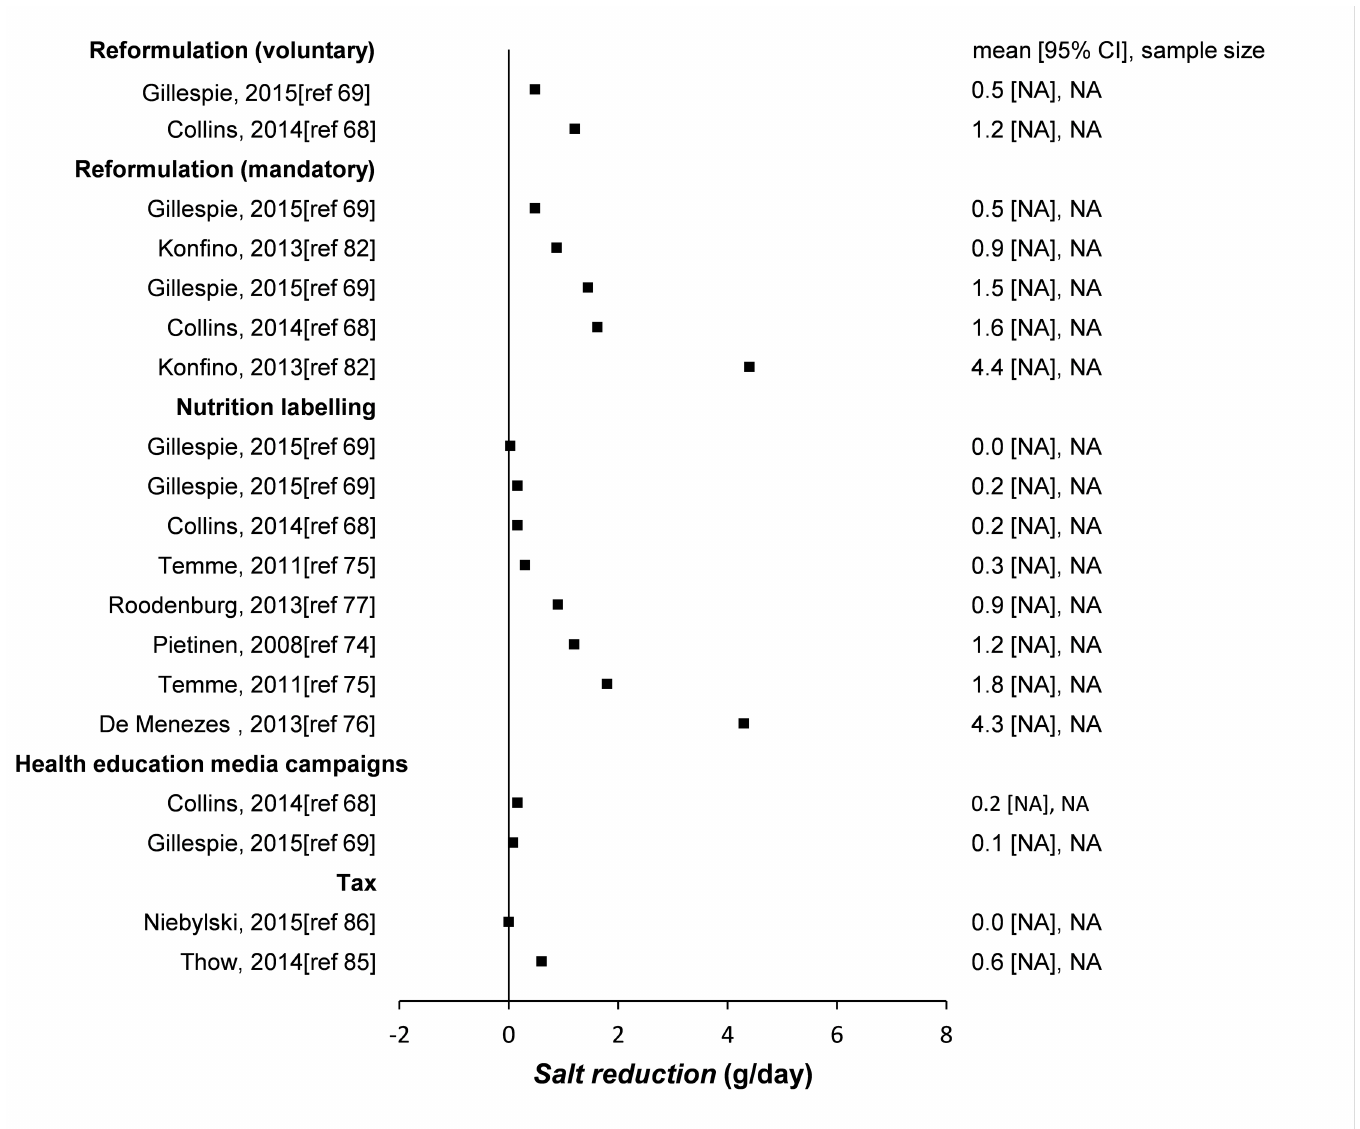
Fig 4. Effectiveness of interventions to reduce salt intake (modelling studies). Forest plot of the modellingstudies that were includedin this systematic review. Because of the different modelling approachesin these studies, their uncertainty measuresare not comparable. Therefore we do not plot them in this graph. Different scenarioswere considered for different studies. NA denotes not applicableor not